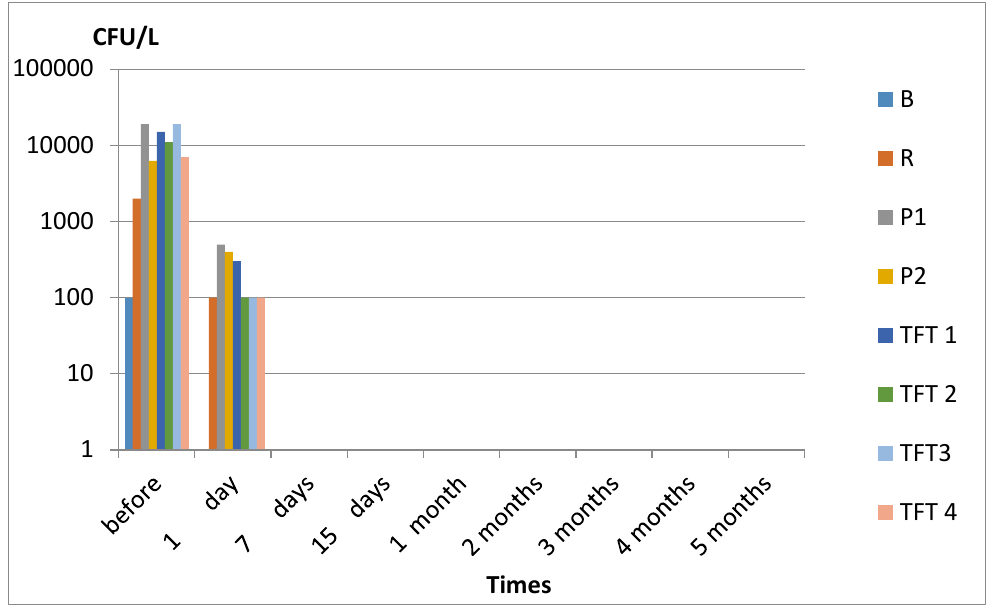
Figure 4. Legionella pneumophila sg1 counts at all the sampling points during the whole period of the study in Hospital 4. B = boiler; R = recirculation; P1 = point 1; P2 = point 2; TFT1 = time flow tap 1; TFT2 = time flow tap 2; TFT3 = time flow tap 3; TFT4 = time flow tap